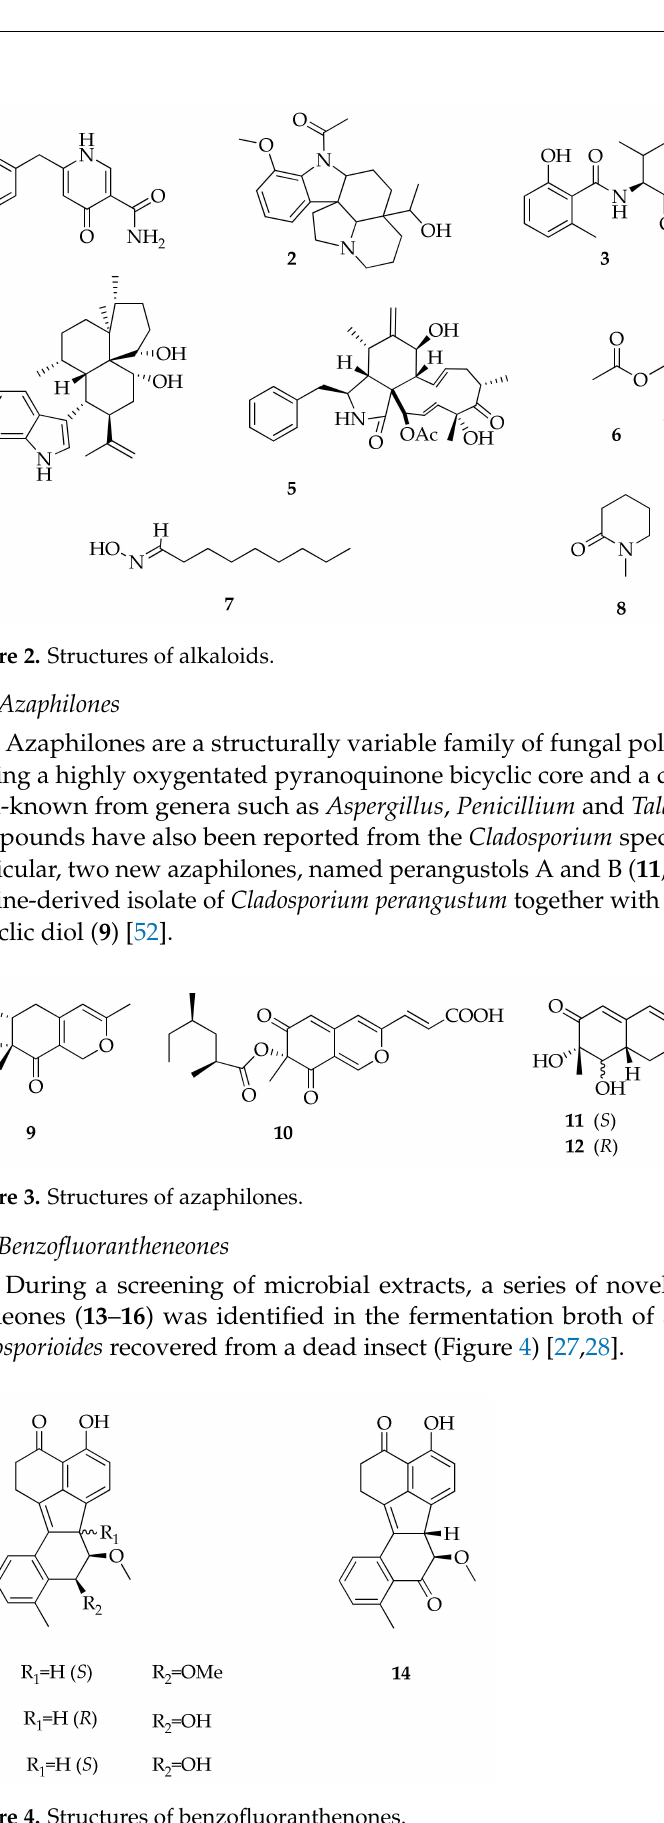
Figure 4. Structures of